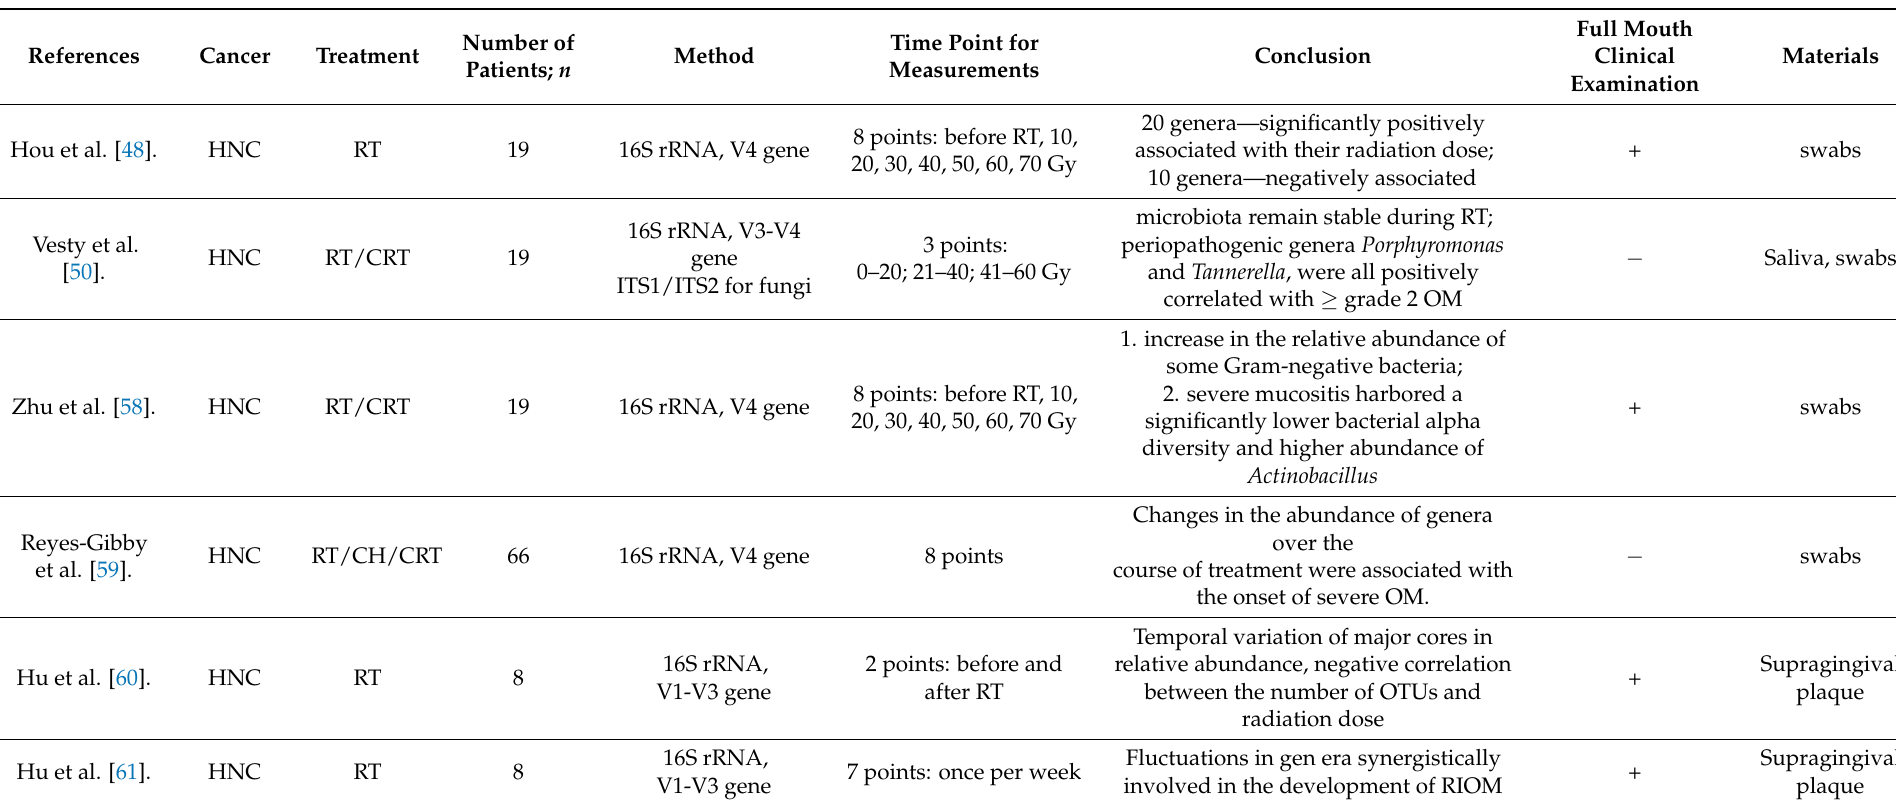
Table 7. Synthesis of studies investigating microbiome during radio- or chemoradiotherapy in patients with head and neck